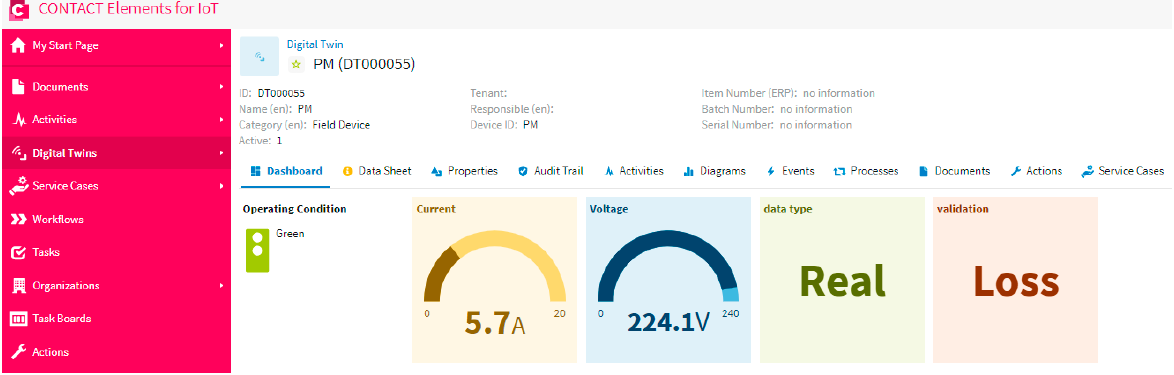
Figure 12. The dashboard of the IoT platform results in the case of testing internet capability.